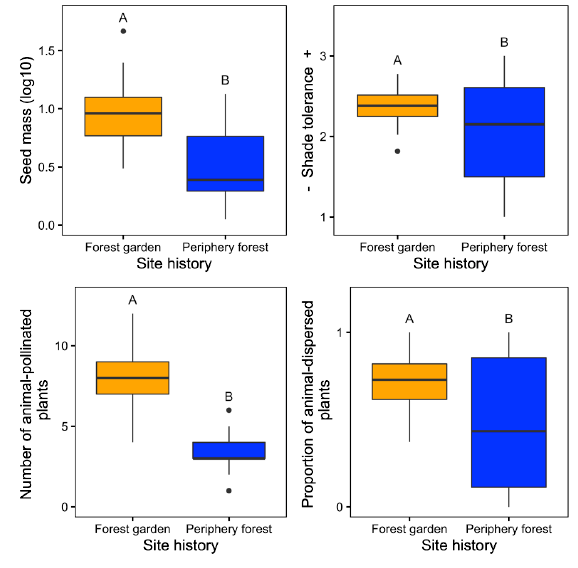
Fig. 4 . Functional Trait Measures between Forest Gardens and Periphery Forests. Comparisons of average seed mass, shade tolerance, pollination syndrome, and dispersal syndrome traits for herbs and shrubs across forest gardens and peripheral forests — all are significantly higher in the forest gardens.